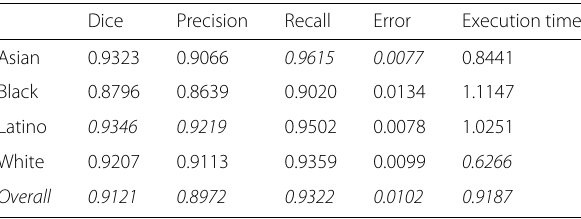
Table 1 Parameter values for the grid search Parameter